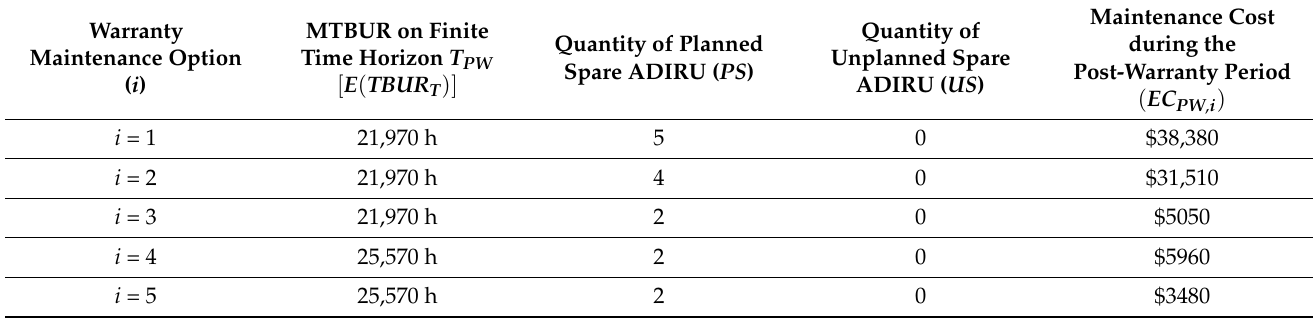
Table 2. The results of the calculations for the five post-warranty maintenance